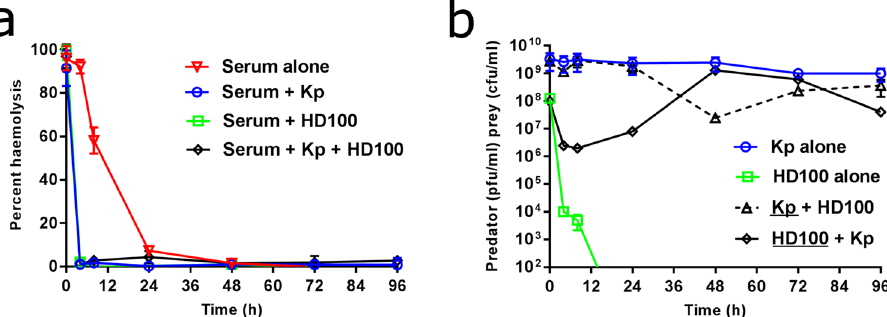
Figure 7. ( a ) Classical pathway complement activity of human serum incubated in presence of predator and/or prey as measured by percent haemolysis of sensitised erythrocytes. Human serum was incubated at 37 °C alone as a control (Serum alone) or in the presence of K. pneumoniae (Serum + Kp), in the presence of B. bacteriovorus HD100 (Serum + HD100) or in the presence of both K. pneumoniae and B. bacteriovorus HD100 (Serum + Kp + HD100). Serum was periodically sampled, filtered (0.2 µ M) and diluted to 25% prior to measuring serum complement activity as determined by percent haemolysis of erythrocytes. CH 50 serum values were calculated from these data and these are included in supplementary materials, Supplementary Table S1. ( b ) Enumeration of live bacterial populations incubated in human serum used for determining classical pathway complement activity. Predator and prey numbers in human serum were determined immediately prior to filtering (0.2 µ M) and filtered aliquots were subsequently used for determining complement activity (panel